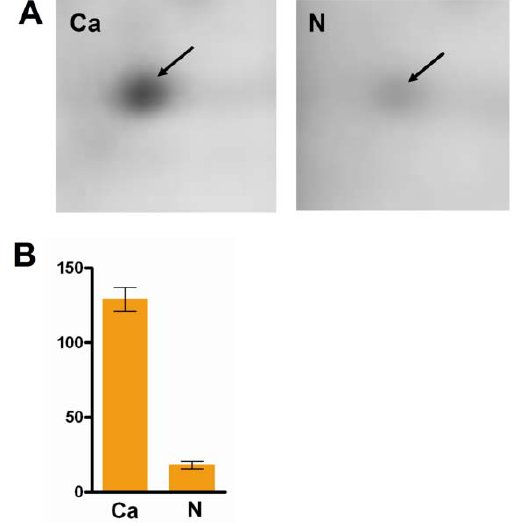
Figure 1. Cropped 2-DE gel images of HSP90 in the serum of hepatocellular carcinoma patients and normal healthy controls. HSP90 was shown the most significant differences in expression between HCC (129.0 ± 4.583) and normal healthy controls (18.33 ± 1.453) (P < 0.0001). It was up-regulated more than 7-fold in the serum of HCC when compared with the normal healthy controls. Ca, carcinoma; N, normal healthy